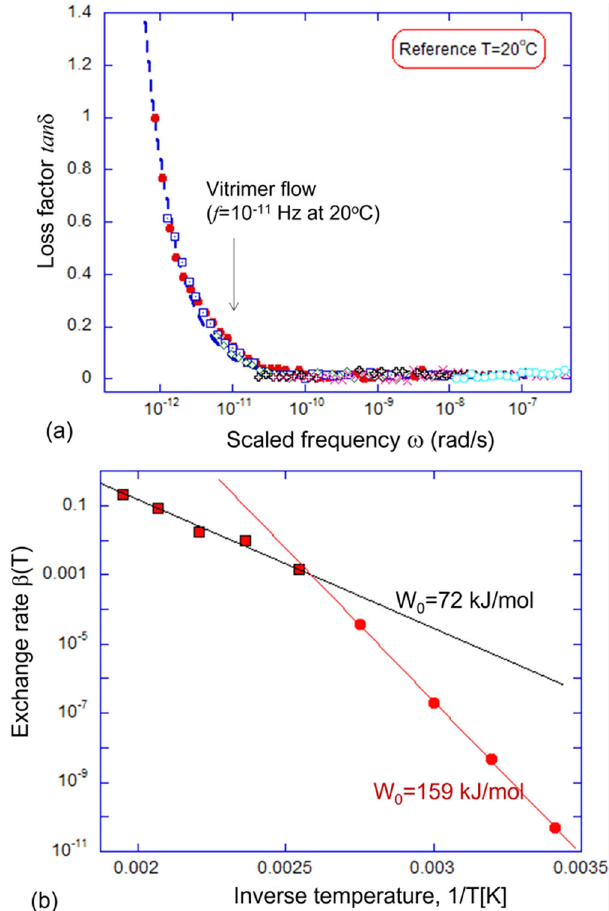
Fig. 3 | Analysis of elastic-plastic transition. a The fi tting of the low-frequency `tail' of the Master Curve in Fig. 2b to the equation tan δ ð ω Þ = β = ω (blue dashed line). Carrying out this fi tting for the same Master Curve re-scaled for various referencetemperatures,weobtainasetofvaluesforthemodelexchangerate β ( T ). b The Arrhenius thermal activation plot of β ( T ) against inverse temperature, the slopeofwhichallows to fi nd the activation energy. We found a dramatic changein thisslope(andtheactivationenergy),whichgives W 0 =72kJ/molforthecurvesfor high temperatures ( T ≤ 120°C) — but a much higher W 0 =159kJ/mol for the lower temperature where the effects of the glass transition become noticeable.